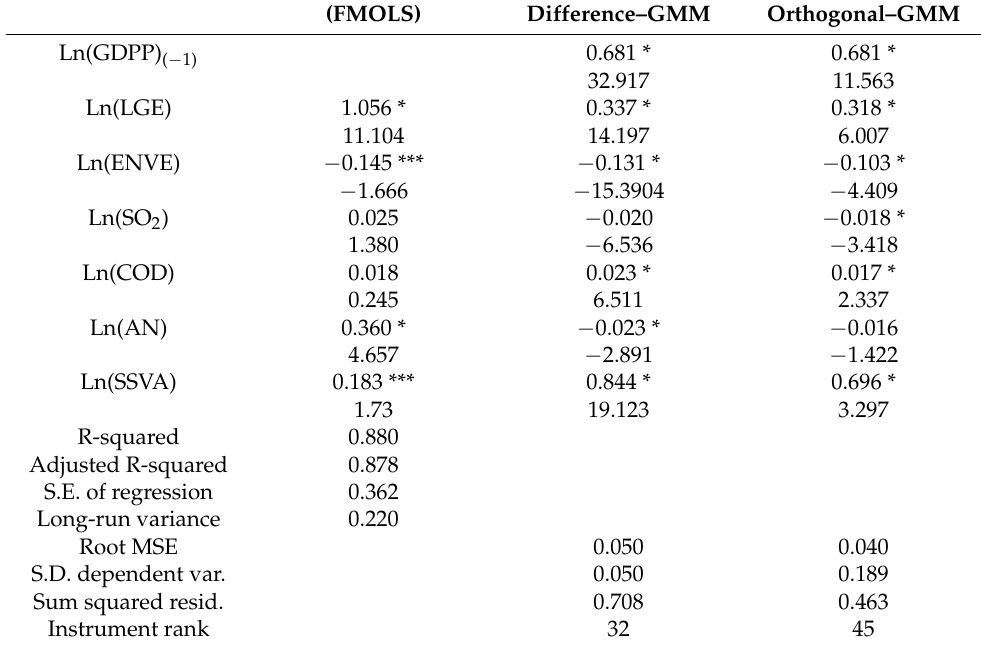
Table 3. Results for the second-stage estimation: nexus between the three pollutant emissions factors SO 2 , COD, and AN emissions, and provincial economic growth per capita